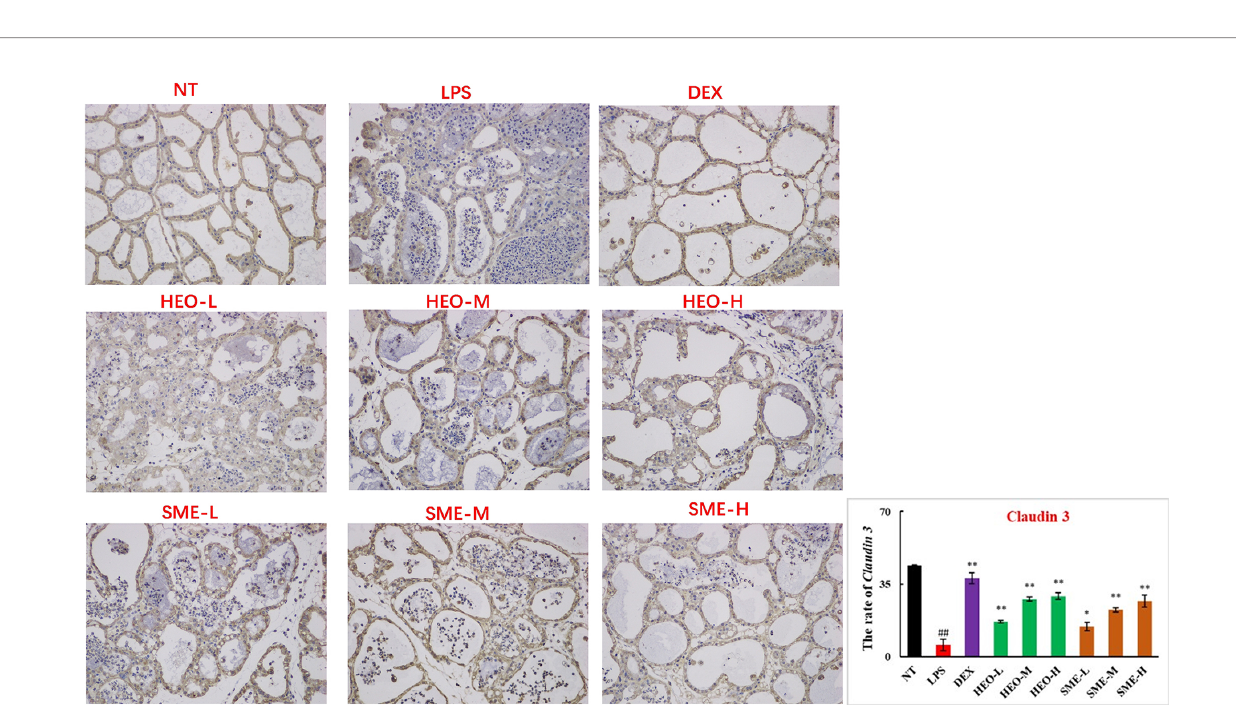
Frontiers in Immunology |